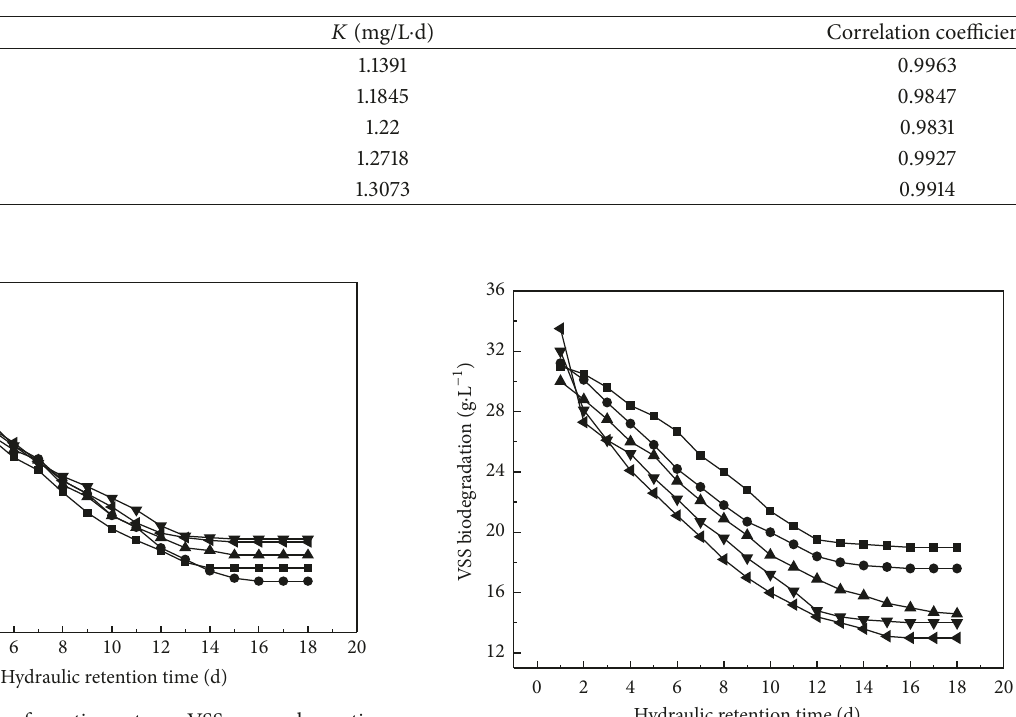
Figure 4: The influence of aeration rate on VSS removal. aeration rate/L ⋅ h −1 : ◼ 10; e 15; 󳵳 20; 󳶃 25; 󳶣 30.